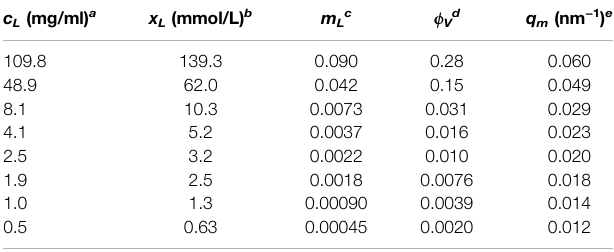
TABLE 1 | Summary of lipid concentrations and corresponding vesicle volume fractions in the studied